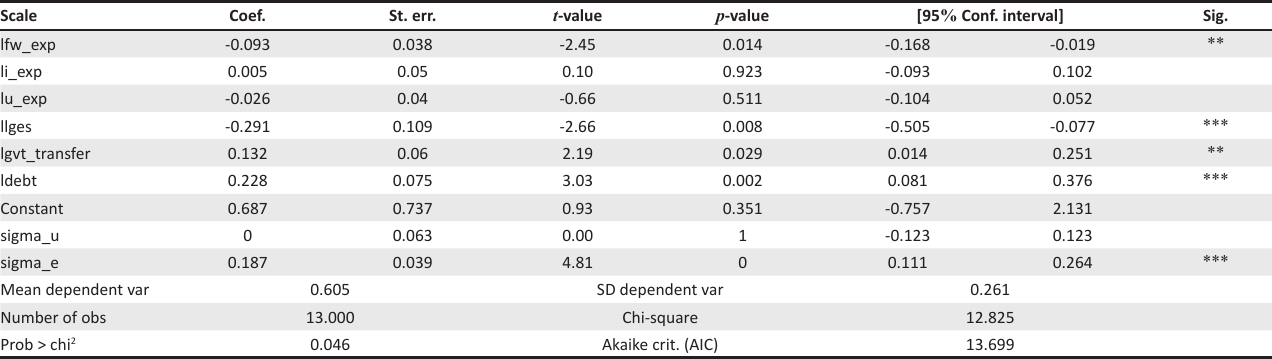
TABLE 4-A1: Random-effects tobit